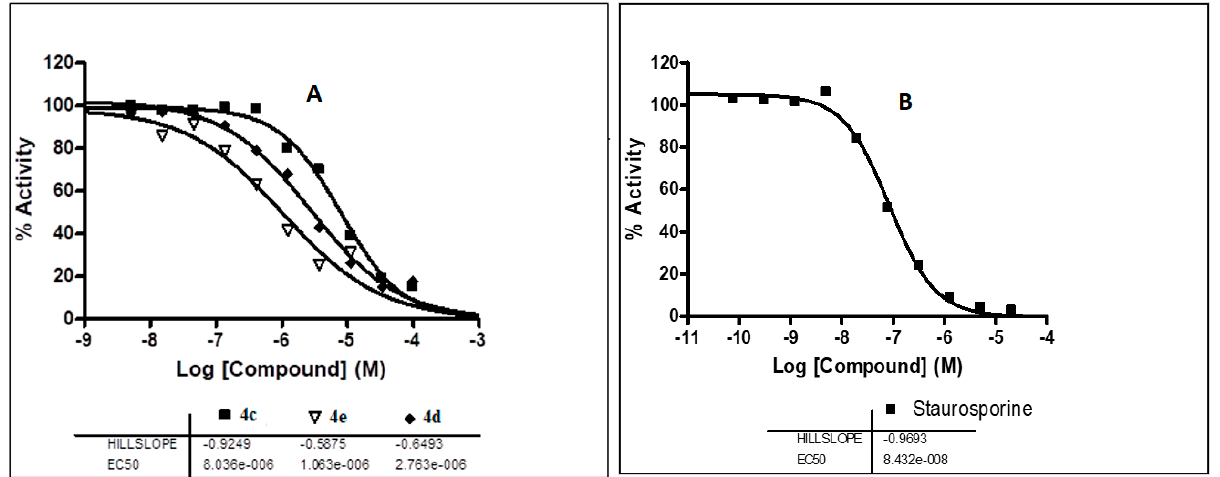
Figure 6. The IC 50 values of compounds 4c , 4e , 4d ( A ) and staurosporine over EGFR ( B ). Table 6. % Inhibition values of compound 4c over a panel of different kinases. Average % Enzyme Inhibition Kinase